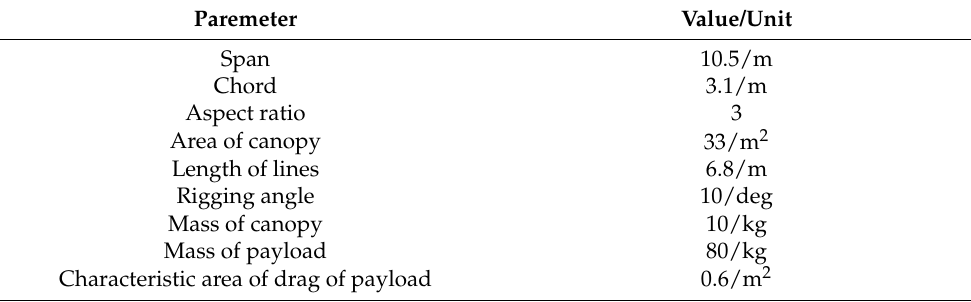
The bandwidth parameterization method was used to design the gain of the